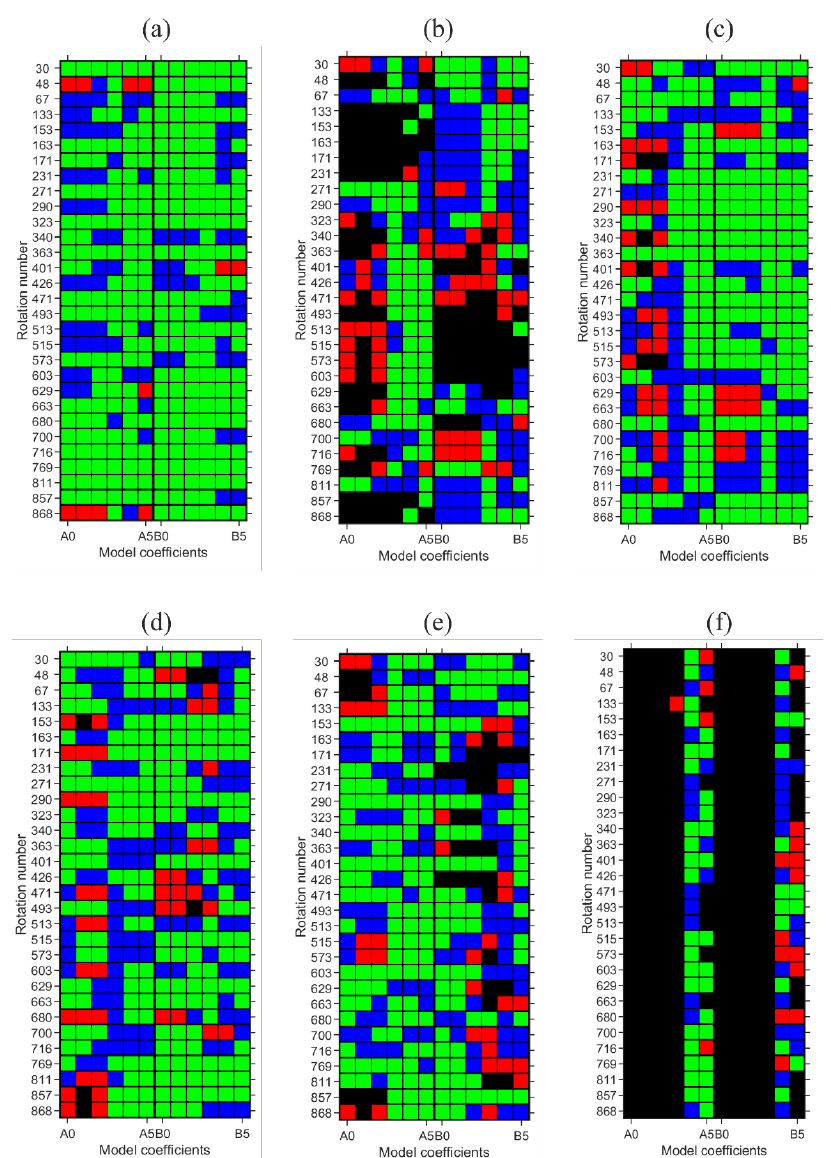
Figure 8. The damage map of bearing (drive side) SKF 1207K: ( a ) undamaged; ( b ) with a damaged outer race; with the cut ball at the depth of: ( c ) 1 mm; ( d ) 2 mm; ( e ) 3 mm; ( f ) with cut inner race.